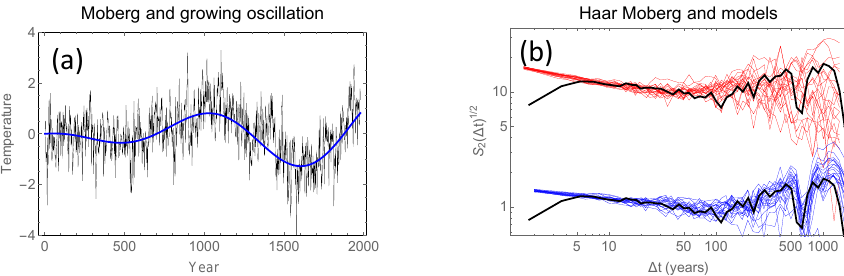
Figure 8. (a) The Moberg reconstruction (black). A fit of the function At sin [ ω ( t − ϕ ) ] (blue). (b) Black curves are the Haar fluctuation function of the Moberg record; the upper curve is multiplied by 10. The red curves are Haar fluctuation functions of 20 realizations of a model comprised of a linear combination of an fGn with β = 0.6 and an fBm with β = 1.6. The blue curves are the same of a model comprised of a linear combination of an fGn with β = 0.6 and the trend At sin [ ω ( t − ϕ ) ]